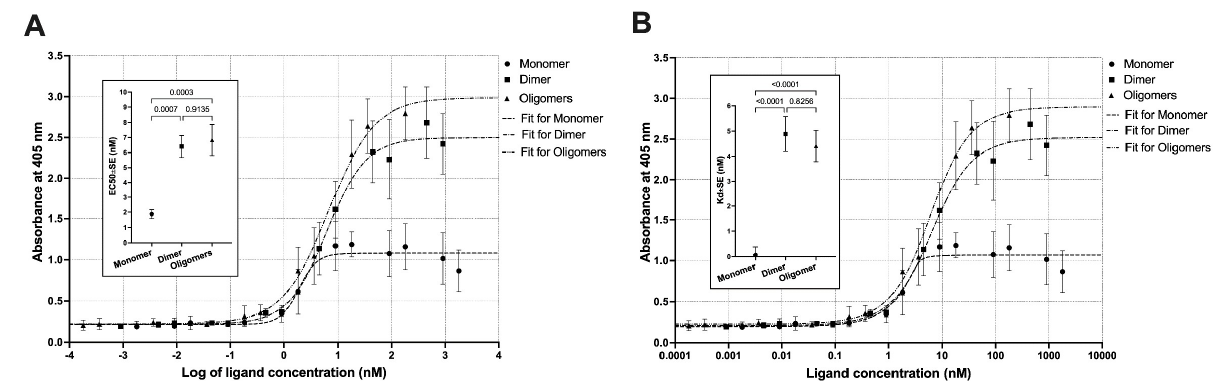
Figure 9 . Non-linear regression of the ELISA experimental data for the titration of IL13RA2 receptor with the cytotoxin monomer, dimer, and oligomers. Two models were used: ( A ) sigmoidal, to derive EC 50 , and ( B ) quadratic, to derive apparent K d values. The inlet graphs present the fit parameters, EC 50 or K d , and p-values for the pairwise comparisons by one-way ANOVA.